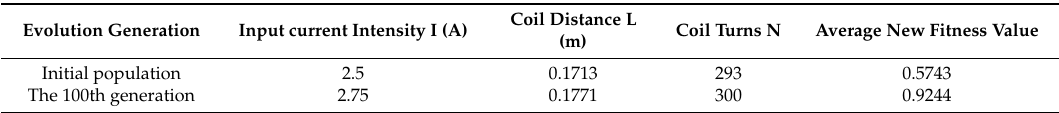
Table 3. Comparison of detection platform variables before and after Genetic Algorithm optimization (the individual with maximum new fitness value).